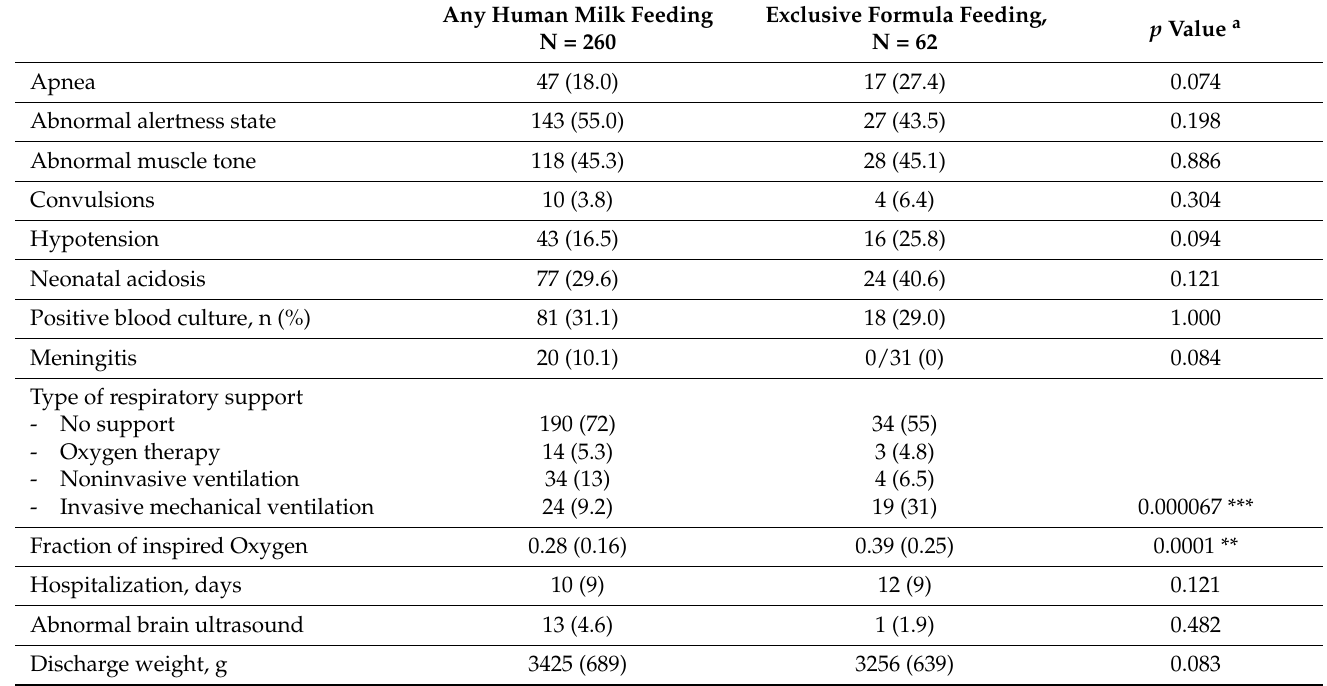
Table 2. Clinical outcomes by feeding